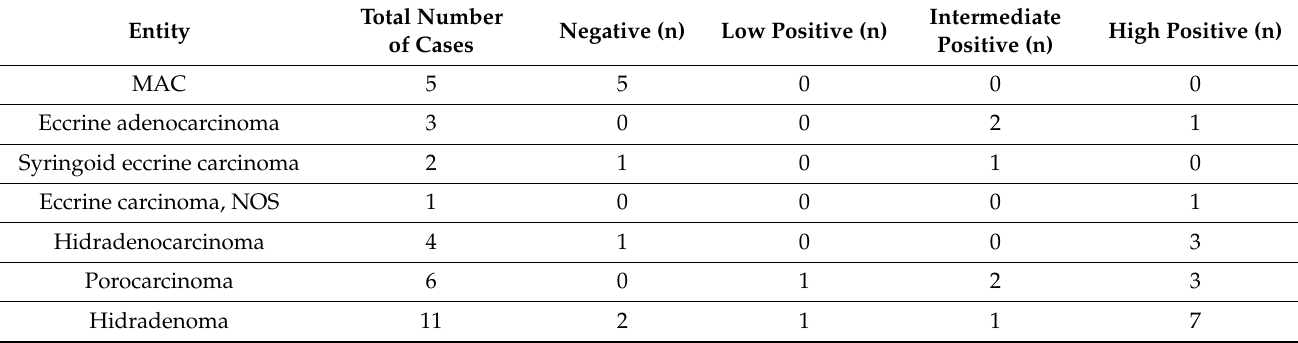
Table 1. Number of cases in each diagnostic group and their distribution among result